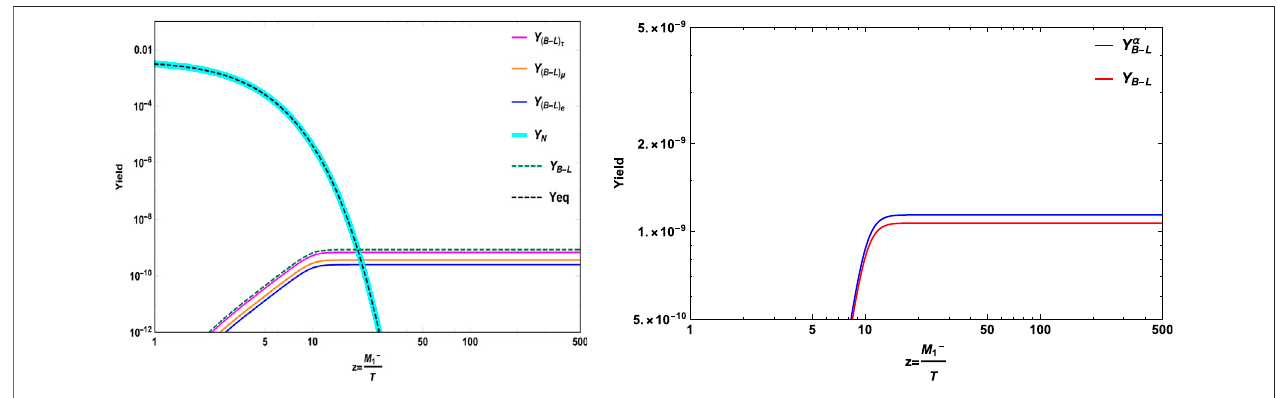
FIGURE 6 | After including the fl avor effects, the yield is shown in the left panel, whereas the right panel shows the enhancement in the yield due to fl avor effects.